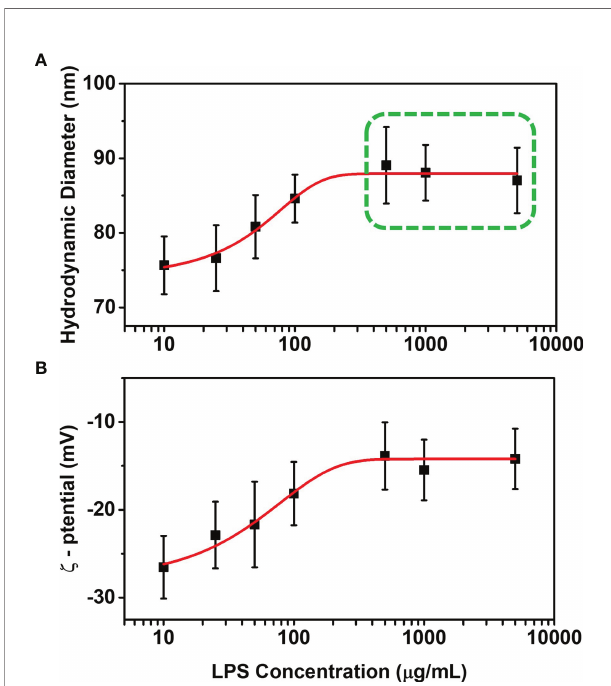
FIGURE 2 | DLS analysis and estimation of the LPS corona. Hydrodynamic diameter (A) and z -potential (B) of AuNPs incubated with different LPS concentrations. The hydrodynamic diameter of bare AuNPs is 67 ± 5 nm, and their z -potential is -32 ± 5 mV (see ). In panel A, hydrodynamic diameter values used for LPS corona estimation on 50 nm AuNPs in saturation condition are highlighted with a green dashed square. Results are reported as mean ± SD of data from 4 independent